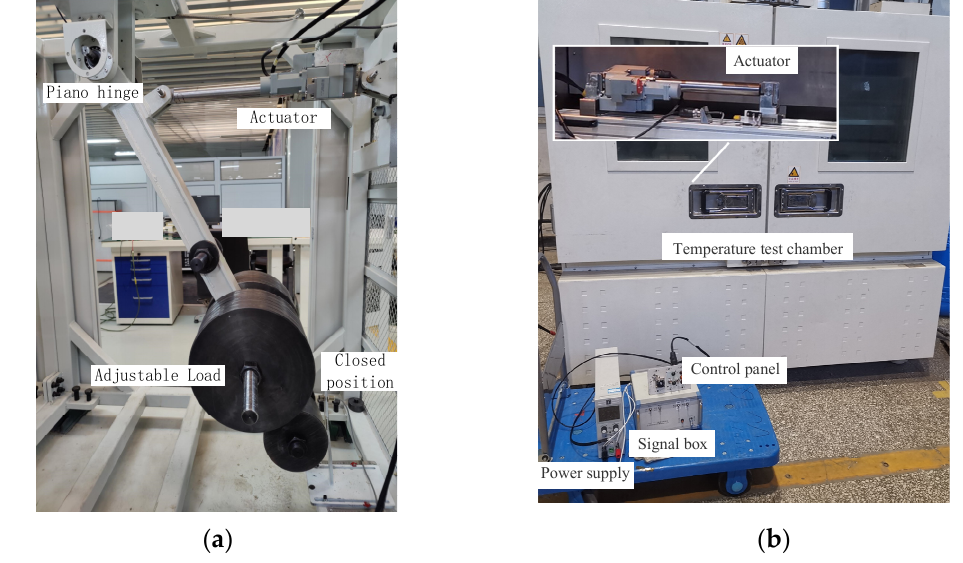
Figure 11. ( a ) Actuator experiment with load at 25 ◦ C and ( b ) without load at − 50 ◦ C. The loaded experiment was made on a gravity load test platform, which is similar to a real cargo door. By adding the adjustable steal slices on the platform, the maximum load of the PMSM was set to 1 Nm, as shown in Figure 11a. In the power closed loop, the power current 𝐼 (cid:3031)(cid:3030)∗ was set to 22 A. It can be seen from Figure 12a (𝐼 (cid:3044)∗ ) that the hybrid controller switches the 𝐼 (cid:3044)∗ between the output of the speed closed loop and power closed loop smoothly, the speed of the actuator slows down when the torque is getting bigger (Figure 12a (speed)), and the power current is under control (Figure 12a (𝐼 (cid:3031)(cid:3030) ) ). By applying the hybrid control strategy, the frequency of the current protection is decreased to zero. The time of the whole movement is ensured to be less than 40 s. At low temperature ( − 50 °C ) , the frictional force gets much larger because of the lu- bricating grease. The EMA was installed on the unloaded platform, placed in the temper- ature test chamber, and operated by the control panel outside the chamber, as shown in Figure 11b. The result is shown in Figure 12b. By setting the power current to a different value (17 A), the system can work efficiently too.